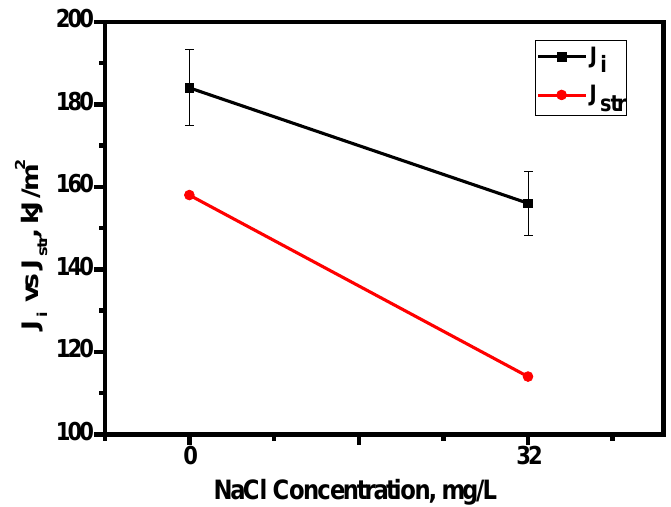
Figure 14. Variation of J i and J str of MAS specimens with E80 test environment.